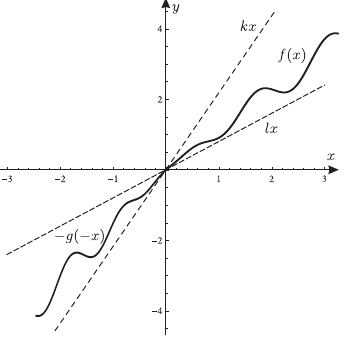
Figure 3. Visualization of sector-bounded nonlinearity f ( x + ) − g ( x −